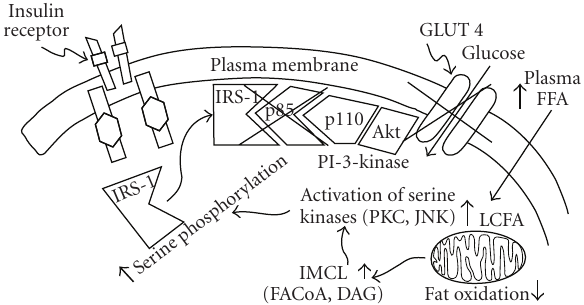
Figure 5: In insulin resistant individuals insulin signaling is impaired at the level of IRS-1 leading to decreased glucose transport/phosphorylation/metabolism and impaired nitric oxide synthase activation/endothelial function. Increased intramycellar fat and fatty acid meyabolite content and mitochondrial dysfunc- tion also exist in skeletal muscle in insulin resistant individuals (see text for a detailed